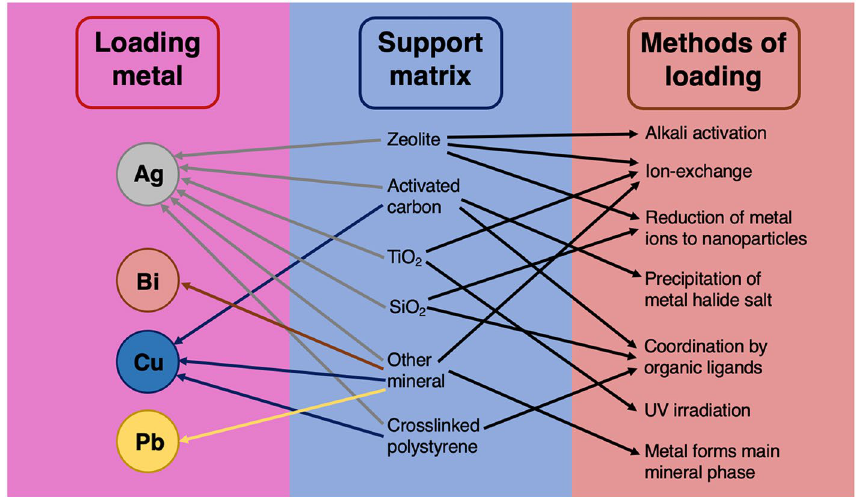
Fig. 3 Overview of known combinations of support, metal and loading mechanisms from the surveyed